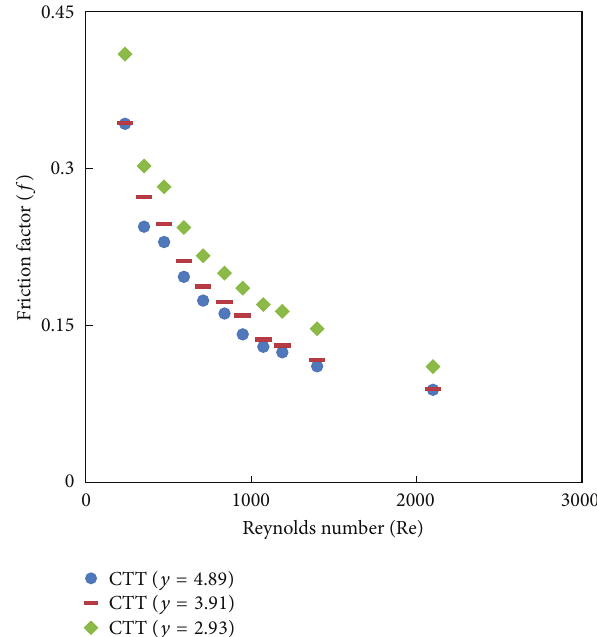
Figure 5: Plain tube simulated friction factor versus the literature data.